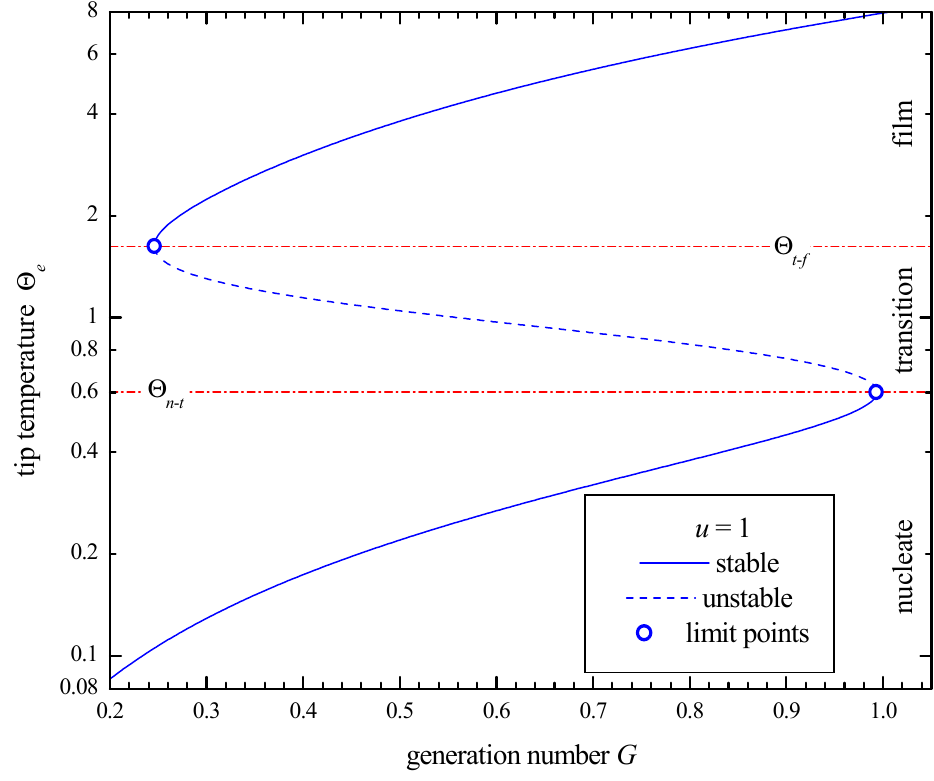
Figure 3. Solution structure for a wire with 𝑢 = 1 .